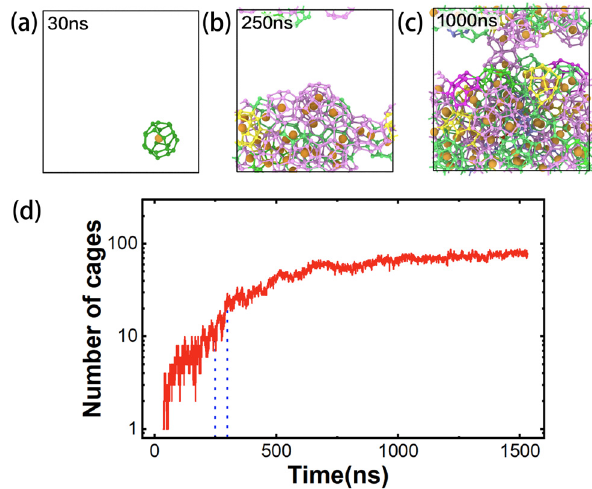
Figure 9: ( a ) – ( c ) snapshots at di ff erent times during the nucleation of clathrate hydrate. The di ff erent types of cage recognized by the HTR algorithm are represented by di ff erent colors: light green, pink, Roland purple, and other colors for 5 12 , 5 12 6 2 , 5 12 6 4 , and other types of cages, respectively. ( d ) Number of newly formed cages in the system along with time.